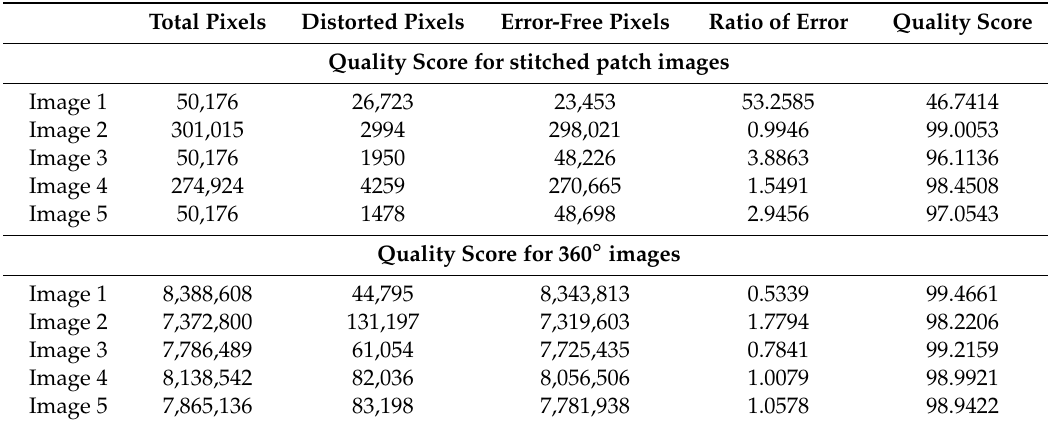
Table 2. The quantitative results obtained for distorted stitched patches and distorted panoramic